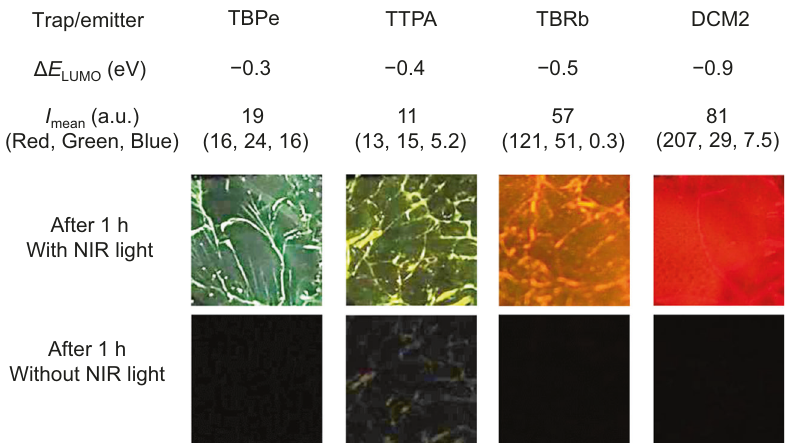
Fig. 3 Color tuning of PSL with different trap/emitter molecules. Molecular structures of trap/emitter molecules and corresponding photographs of the blend fi lms containing different trap/emitter molecules (1 mol%) with and without 800-nm light irradiation after stopping 365-nm light irradiation. The actual size of the fi lms in the images is 5 mm × 5 mm. The difference of LUMO energy ( Δ E LUMO ) was calculated from E LUMO (trap/emitter) − E LUMO (PPT) based on the reduction potentials of the materials (Fig. 1c). The mean intensity ( I mean ) of PSL was calculated from the red, green, and blue components of the color image taken by a digital camera. The exposure time was 10 s. The brightness and contrast of images are different for each sample.